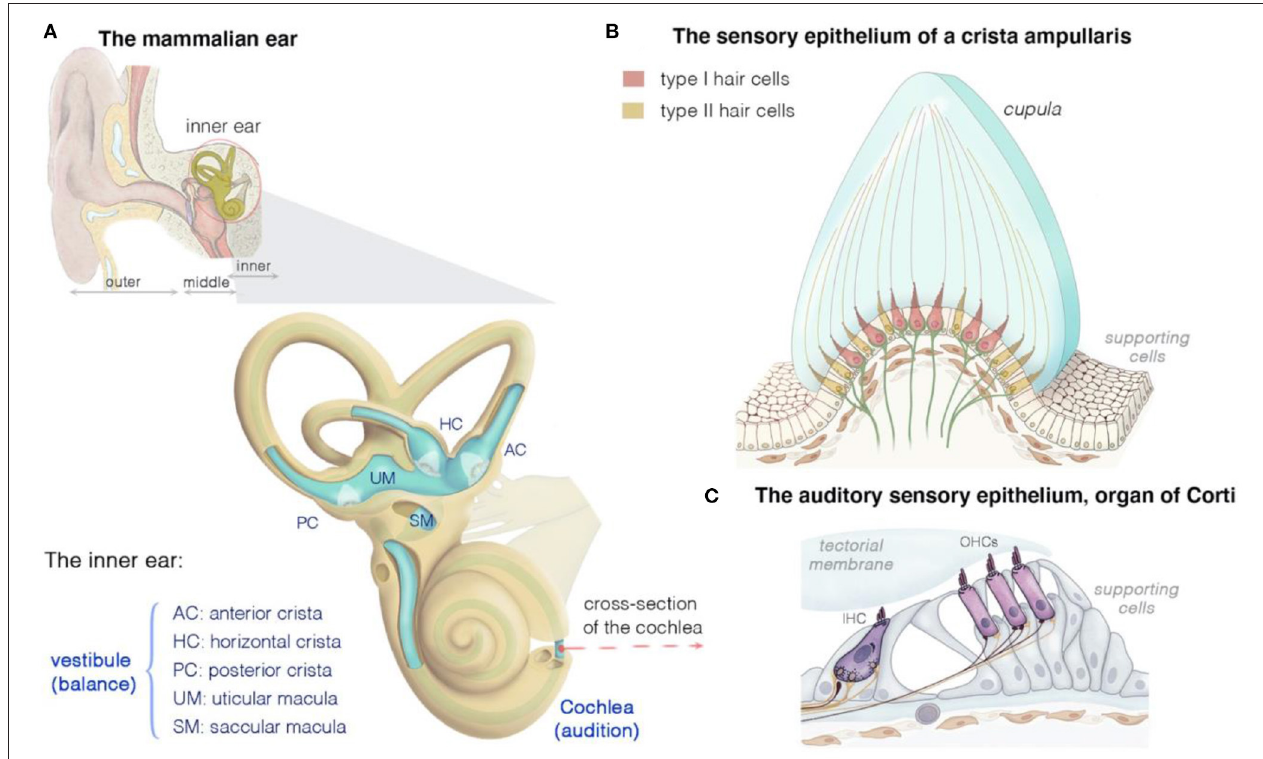
FIGURE 1 | Structure and function of the mammalian inner ear, and of the organization of the vestibular and auditory sensory epithelia. (A) The inner ear houses both the hearing and the balance organs, the cochlea and the vestibule, respectively. The membranous labyrinth of the inner ear consists of three semicircular canals, each ending with an ampulla that form the anterior (AC), horizontal (HC), or posterior (PC) crista, two otolith organs (saccule and utricle), and the cochlea. The calyx- and bouton-like afferent innervation of hair cells is presented in green. (B) Cross section of a crista ampullaris, highlighting the organization of the type I and type II hair cells. All the crista hair cells have hair bundles displaying the same polarity orientation, extending into a gelatinous membrane called the cupula. Details of the macular sensory regions’ organization are shown in Figure 2 . (C) Cross section of the organ of Corti, showing the inner (IHC) and outer (OHCs) hair cells, associated afferent (green) and efferent (dark purple red) neurons and supporting